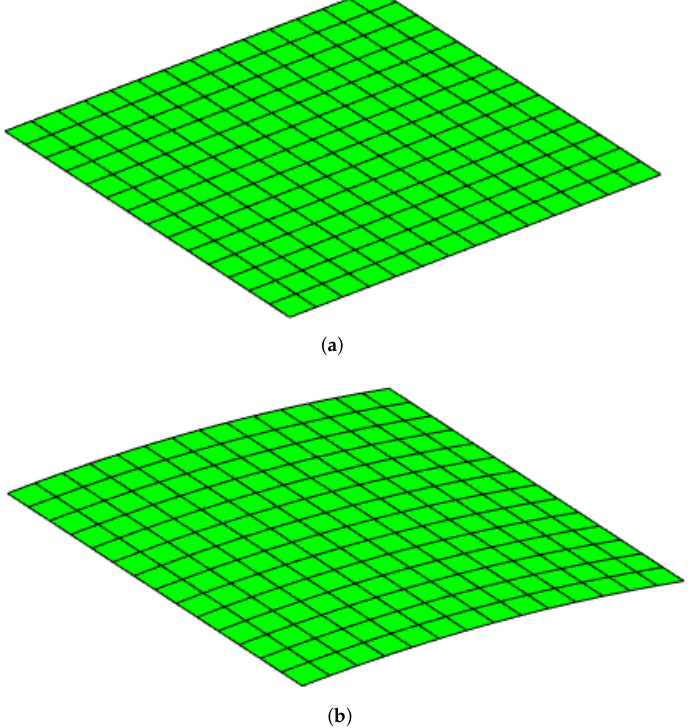
Figure 12. Meshes of 14 × 14 elements of FG-CNTRC membranes with various curvatures. ( a ) κ = 0, ( b ) κ =